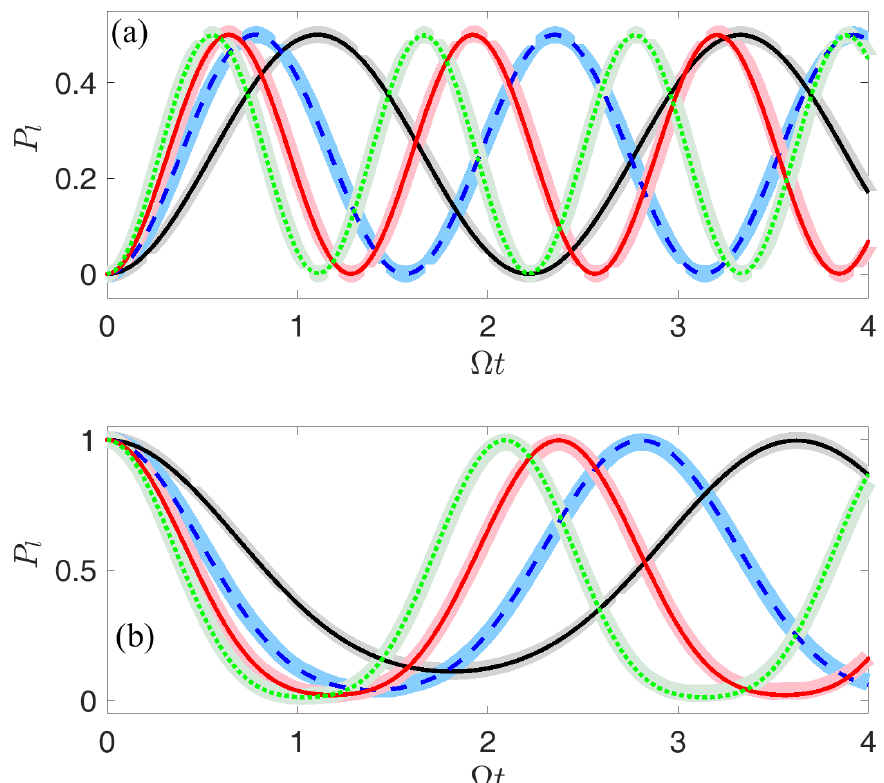
Figure 2. Time evolutions of collective Rydberg excitation probabilities P l are calculated based on the original Hamiltonian (1) (thick curves) and the effective Hamiltonian (3) (thin curves), respectively. The solid black curve, the dashed blue curve, the dashed–dotted red curve, and the dotted green curve denote the different numbers of atoms ( a ): ( m l , m r ) = ( 1,1 ) , ( 2,2 ) , ( 3,3 ) and ( 4,4 ) when the initial state is prepared in | G l (cid:105)| G r (cid:105) and ( b ): ( m l , m r ) = ( 1,2 ) , ( 2,3 ) , ( 3,4 ) and ( 4,5 ) when the initial state is prepared in | R l (cid:105)| G r (cid:105) . Other parameters are given at the beginning of Section